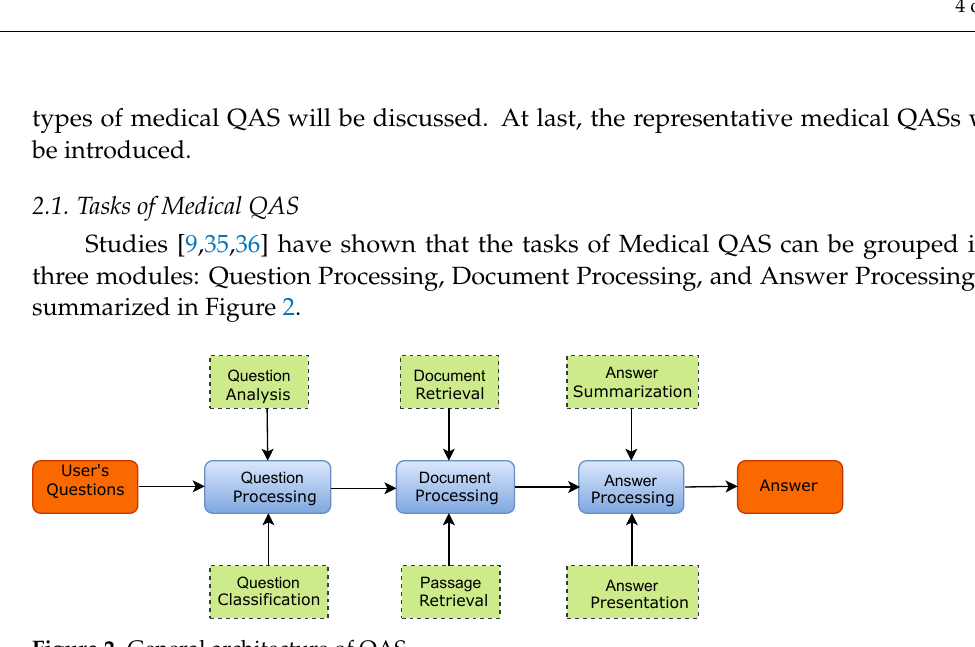
Figure 2. General architecture of